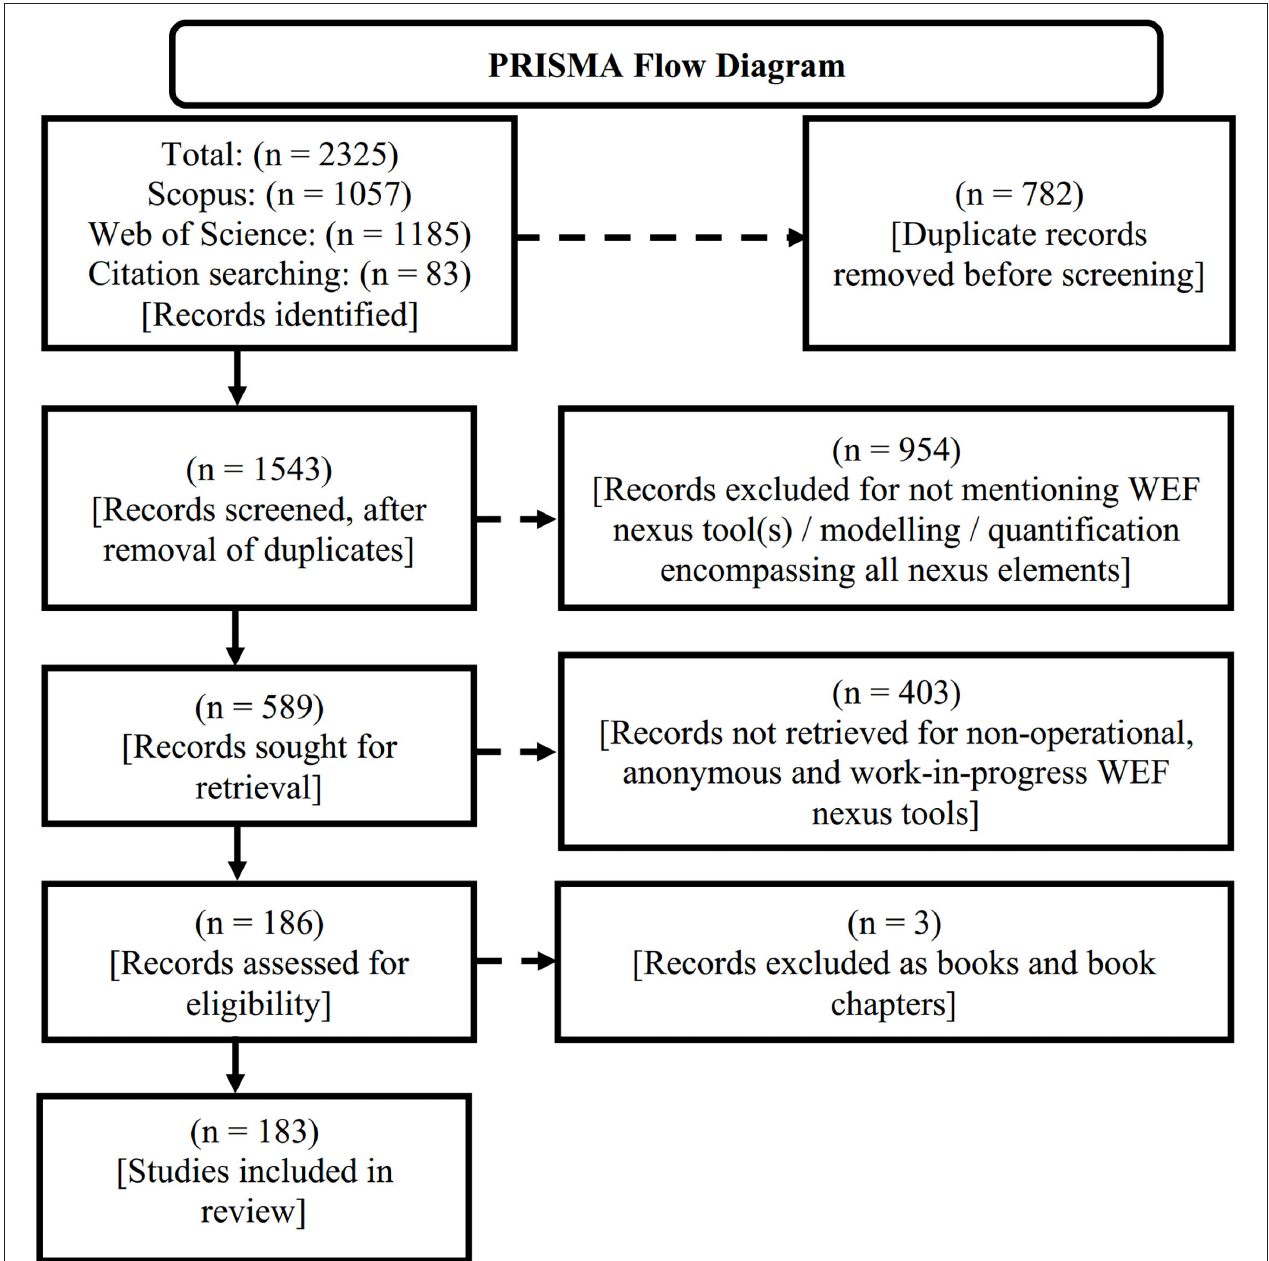
FIGURE 1 | The PRISMA 2020 framework and flow diagram for the systematic review, which includes searches of databases and other sources (adapted from Haddaway et al., 2021a,b and Page et al., 2021a,b).